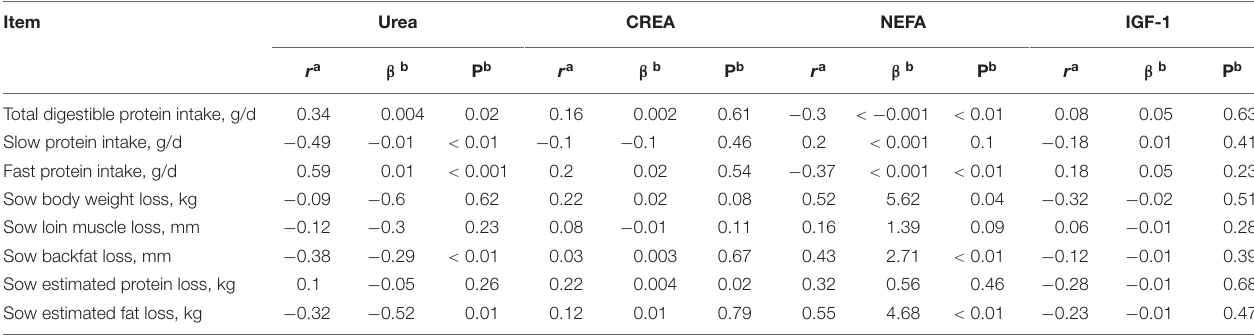
TABLE 8 | Relationships between sow blood plasma urea (mmol/L), CREA ( µ mol/L), NEFA ( µ mol/L), and IGF-1 (ng/ml) levels and sow total protein intake (g/d), sow slow protein intake (g/d), sow fast protein intake (g/d), sow body weight (kg), loin muscle (mm), backfat (mm), estimated body protein (kg), and estimated body fat (kg) loss in a 21-day lactating